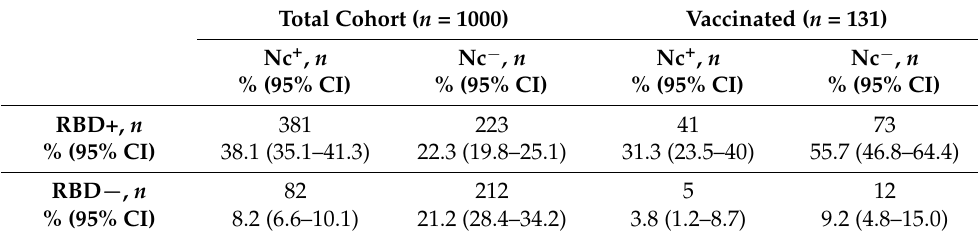
Table 1. Structure of antibody seroprevalence in the fourth